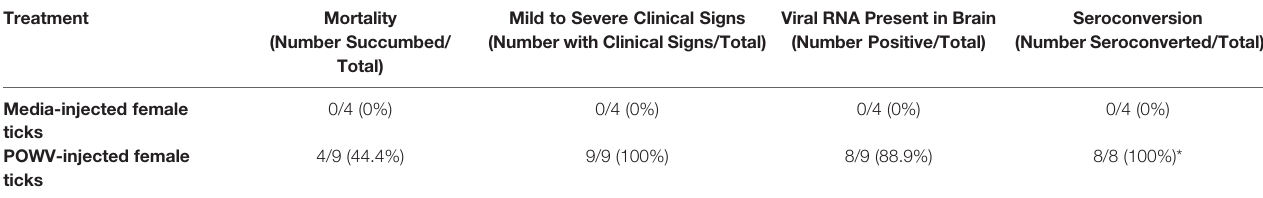
TABLE 2 | Disease in mice infested with POWV-injected adult female H. longicornis . Treatment Mortality (Number Succumbed/